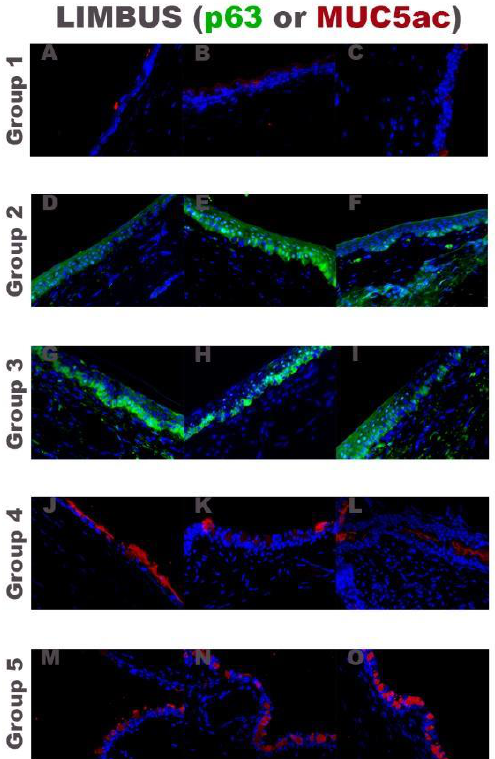
Figure 5. Immunofluorescence analysis of the limbal area with a normal limbal epithelium (p63 in green and DAPI in blue) or with a conjunctival epithelium (MUC5ac in red and DAPI in blue). Group 1: only medical treatment (control group), Group 2: fibrin-PRGF membrane cultured with autologous rabbit LEPCs, Group 3: fibrin-PRGF membrane cultured with heterologous rabbit LEPCs, Group 4: fibrin-PRGF membrane SLET and Group 5: fibrin-PRGF membrane without rabbit cultured LEPCs. 400 × . PRGF: Plasma Rich in Growth Factors; LEPCs: Limbal Epithelial Progenitor Cells; SLET: Simple Limbal Epithelial Transplantation.